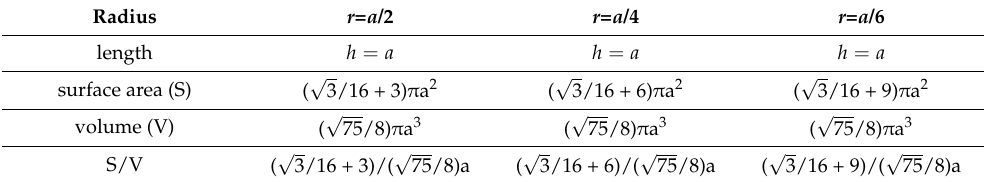
Table 1. Parameters used to calculate S/V ratio of ZnO nanorods in NFAs.